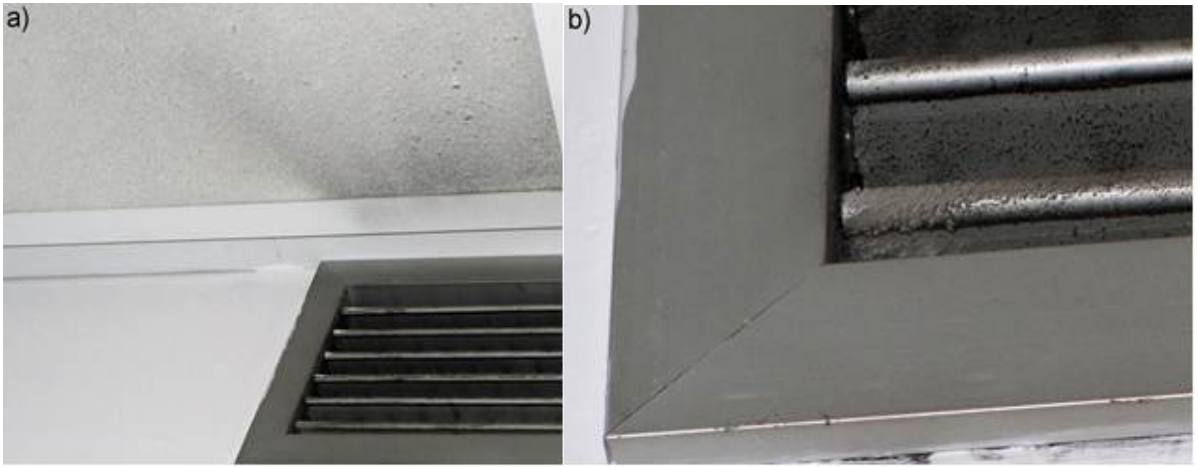
Figure 3. Soiling deposits evidencing circulation of particles ( b is an enlarged portion of a